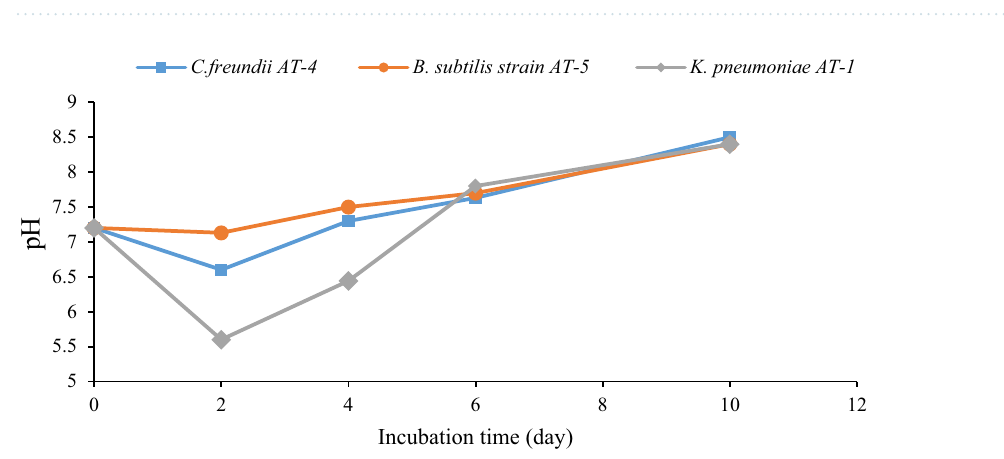
Figure 3. Bacterial culture growth during RPCM effluent bioremediation (effluent + culture + mineral salt + glucose). Note . RPCM: Recycled paper and cardboard mill.